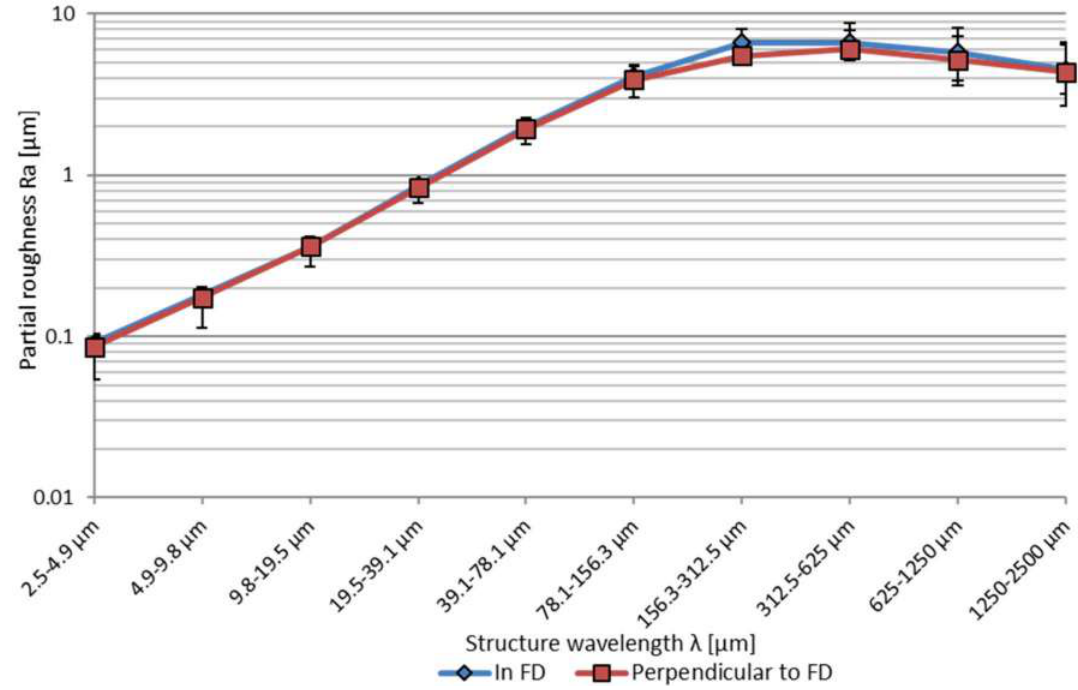
Figure 5. Partial roughness Ra of the vertical fabricated samples (fabrication angle 90 ◦ ), used for the process parameter investigations, depending on the measuring